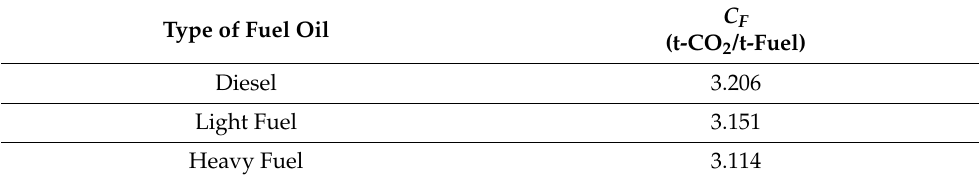
Table 7. CF conversion factor values